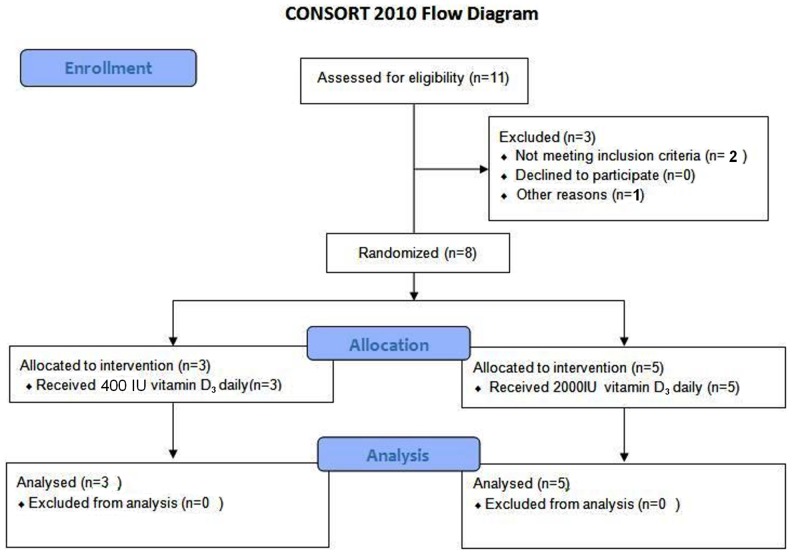
Flow Diagram of Study Subjects.